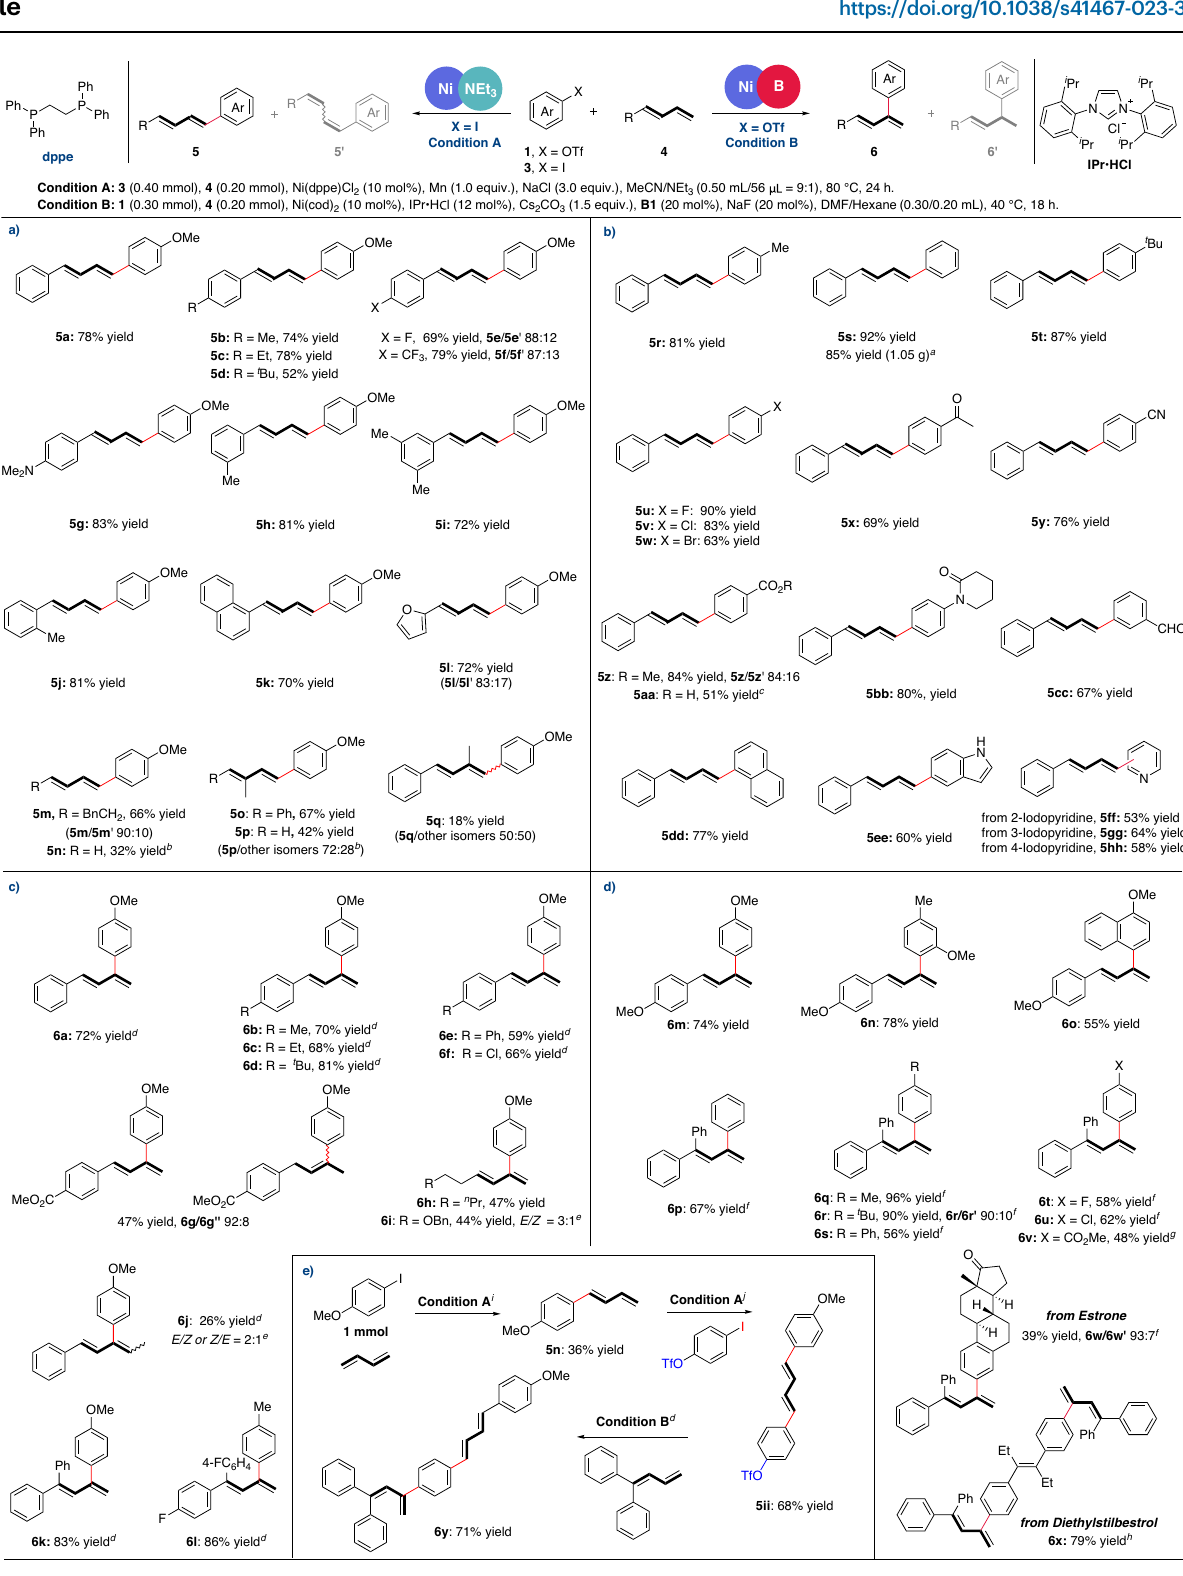
Fig.2|SubstratescopetowardsdivergentHeckreactions.a Substratescopesof dienes for linear products. b Substrate scopes of Ar-I for linear products. c Substrate scopes of dienes for branched products. d Substrate scopes of Ar-OTf for branched products. e Cascade Heck reactions. Isolated yields were given in all cases. Selectivities were >20:1 except for some cases with footnotes, which were determined by GC-FID or 1 H NMR analysis. a iodobenzene (9.0mmol),